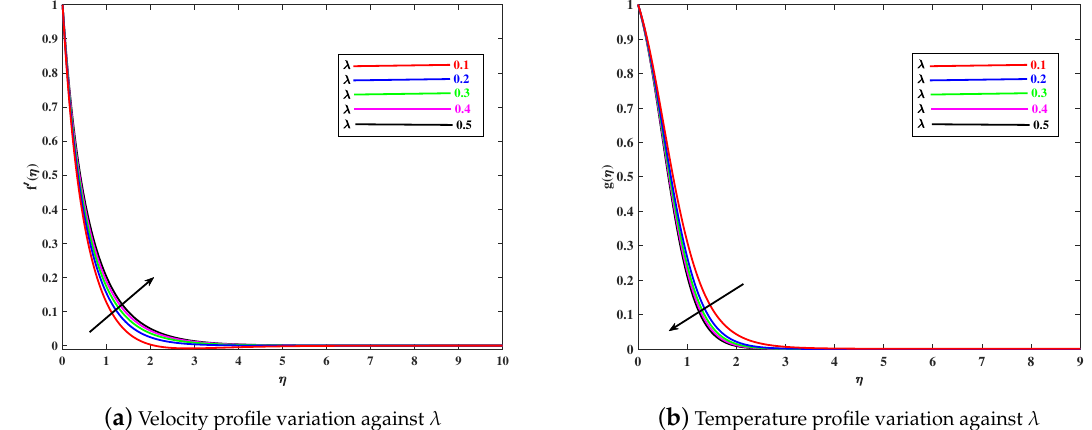
Figure 5. Effect of λ to influence the momentum and thermal profile.